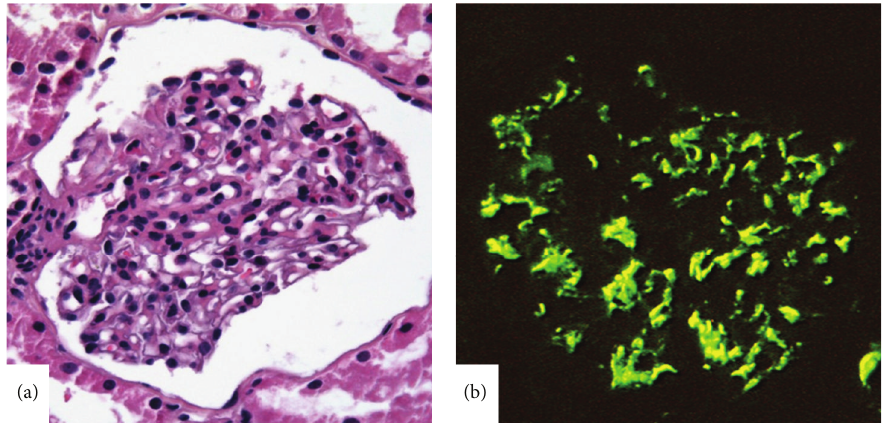
Figure 2: Lupus nephritis class II. (a) Moderate mesangial hypercellularity in the glomerulus (hematoxylin-eosin, × 400). (b) Diffuse and strong mesangial IgG deposition by IFM ( × 400).